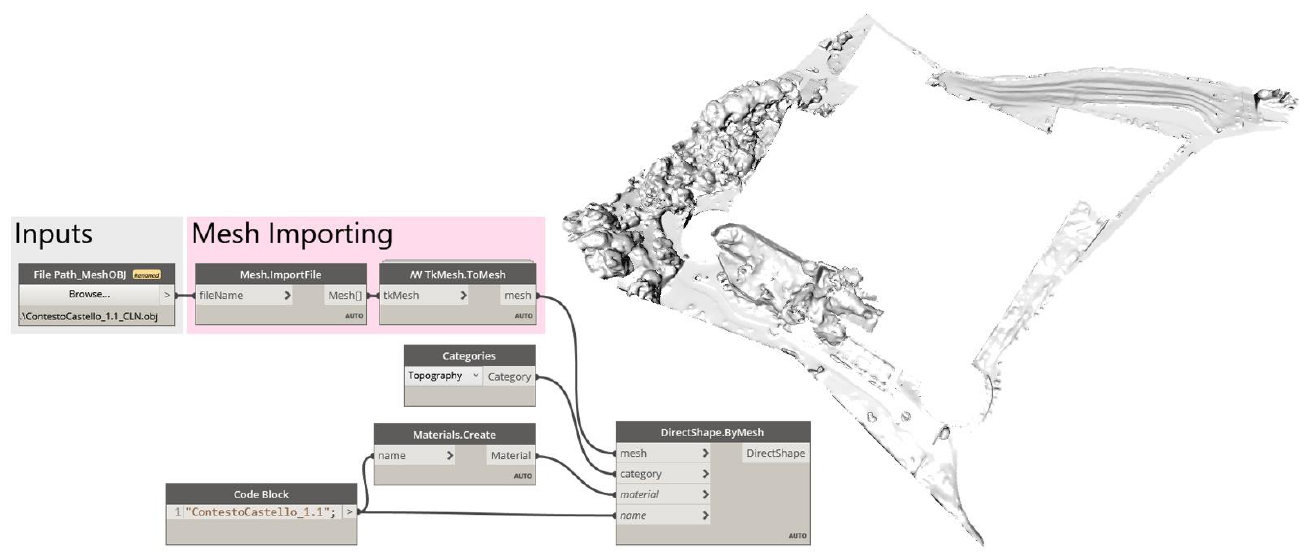
Figure 8. VPL script developed for the Workflow A, in the Dynamo for Revit environment, e.g., the project file “ Context_1.1.RVT ”.